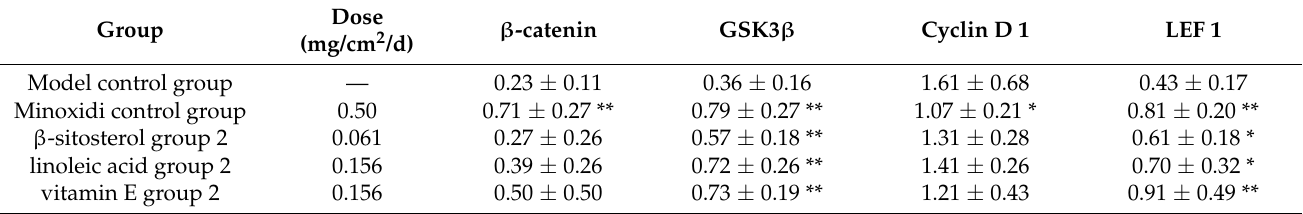
Figure 14. Number of hair follicles and dermal thickness ( × 100). Table 17. Effects of three effective components of the kernel of P. mira on the mRNA expression of four targets in the Wnt/ β -catenin signaling pathway in the skin tissue of C57BL/6 mice (x ± s ).